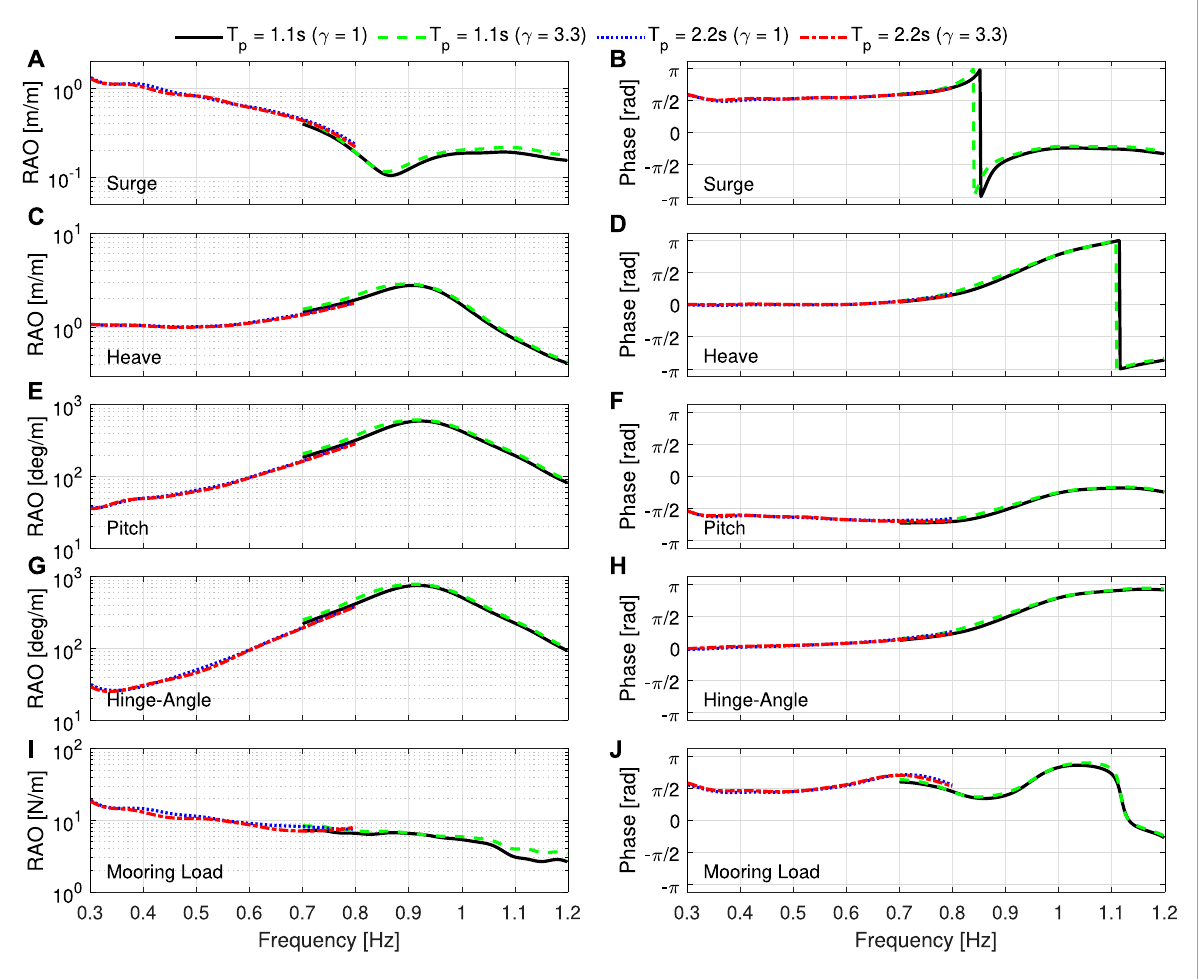
FIGURE 3 The surge (A) , heave (C) , pitch (E) hinge-angle (G) and mooring load (I) RAOs obtained from the 1-h irregular sea states, and the corresponding phase angles (B,D,F,H,J) . Surge, heave and pitch is presented for the front raft only. Each line is a different sea state: 50-year sea state, γ = 1 (black solid), γ = 3 . 3 (green dashed); and Resonance sea state γ = 1 (blue dotted), γ = 3 . 3 (red